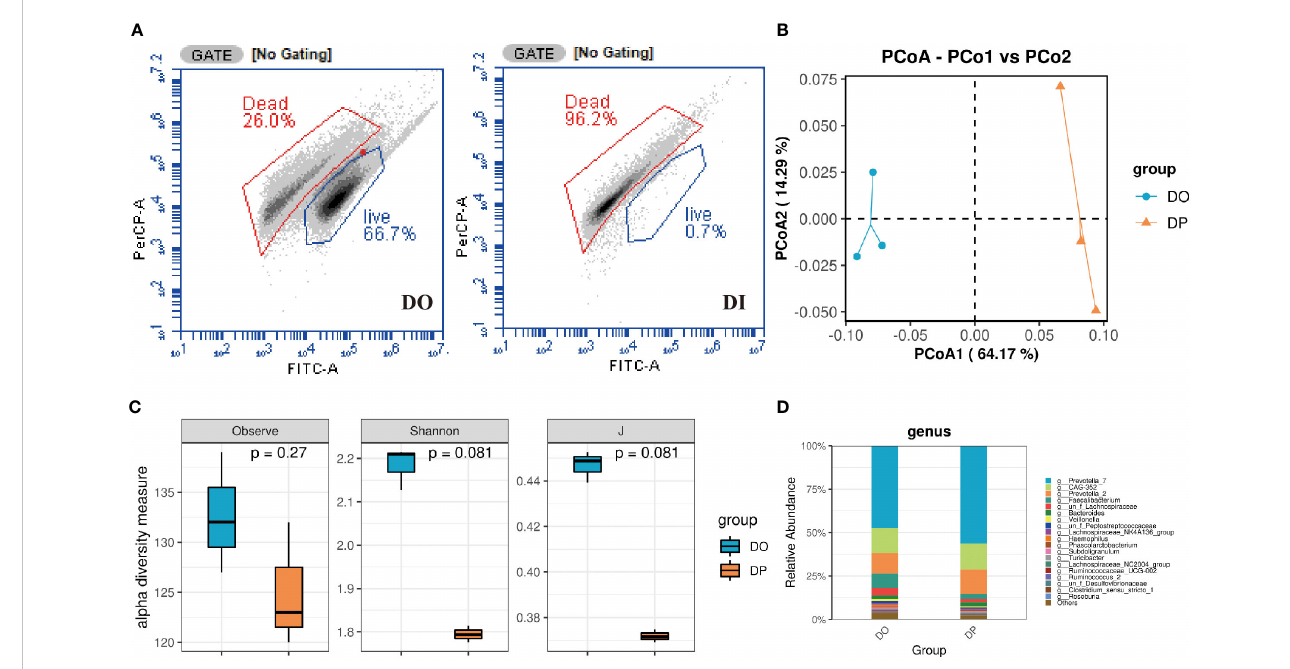
FIGURE 2 Composition of donor gut microbiota before and after PMA treatment turned out. (A) Flow cytometry counts of DO and DI groups. DO, DI and DP samples were analyzed based on 16S rRNA gene sequencing. (B) PCoA analysis; (C) Taxonomic pro fi les at the top 20 genus levels in terms of overall mean relative abundance; (D) microbial alpha diversity as estimated by species richness, the Shannon diversity index, and the Inverse Simpson diversity index(J) based on OTU abundance